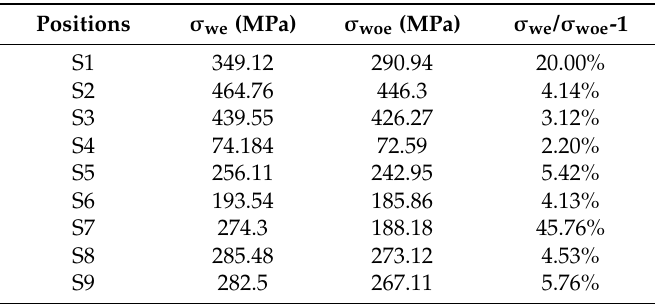
Figure 10. Fast Fourier transform (FFT) of the stress responses without the added mass.